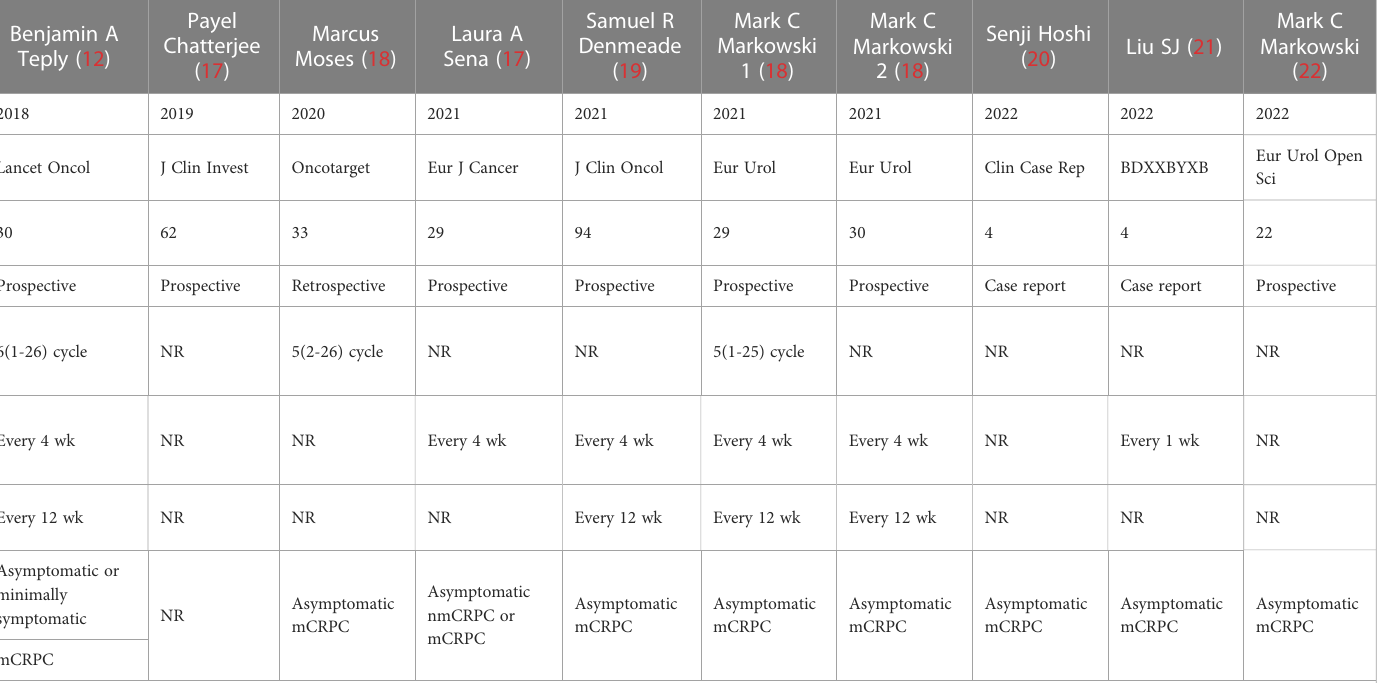
TABLE 1 Characteristics of included